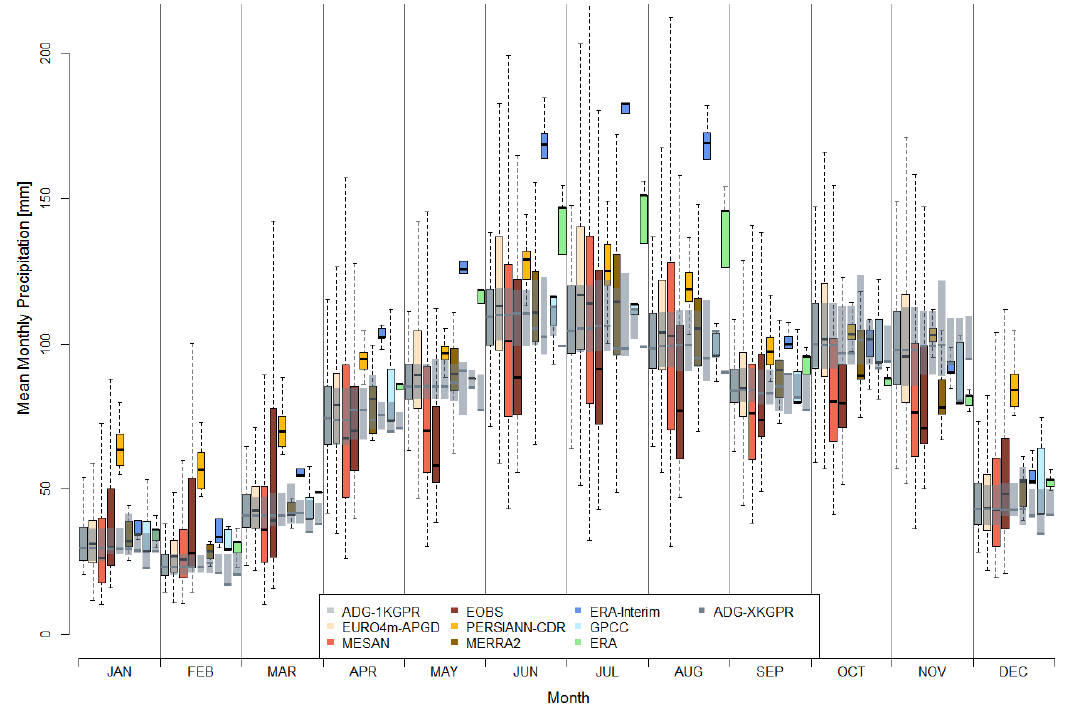
Figure 7. Monthly Precipitation Sums for the applied data sets. The grey boxplots correspond to the high resolution Water Flow and Balance Simulation Model (WaSiM) aggregation, while shaded boxes show the boxplots for the respective grids.